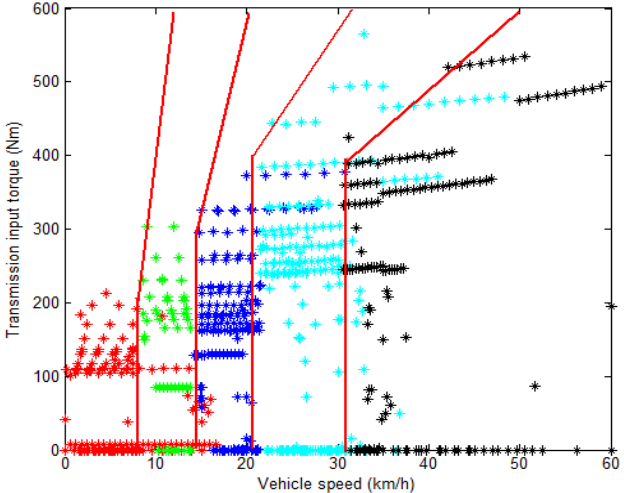
Figure 5. The extracted gear shift schedule.